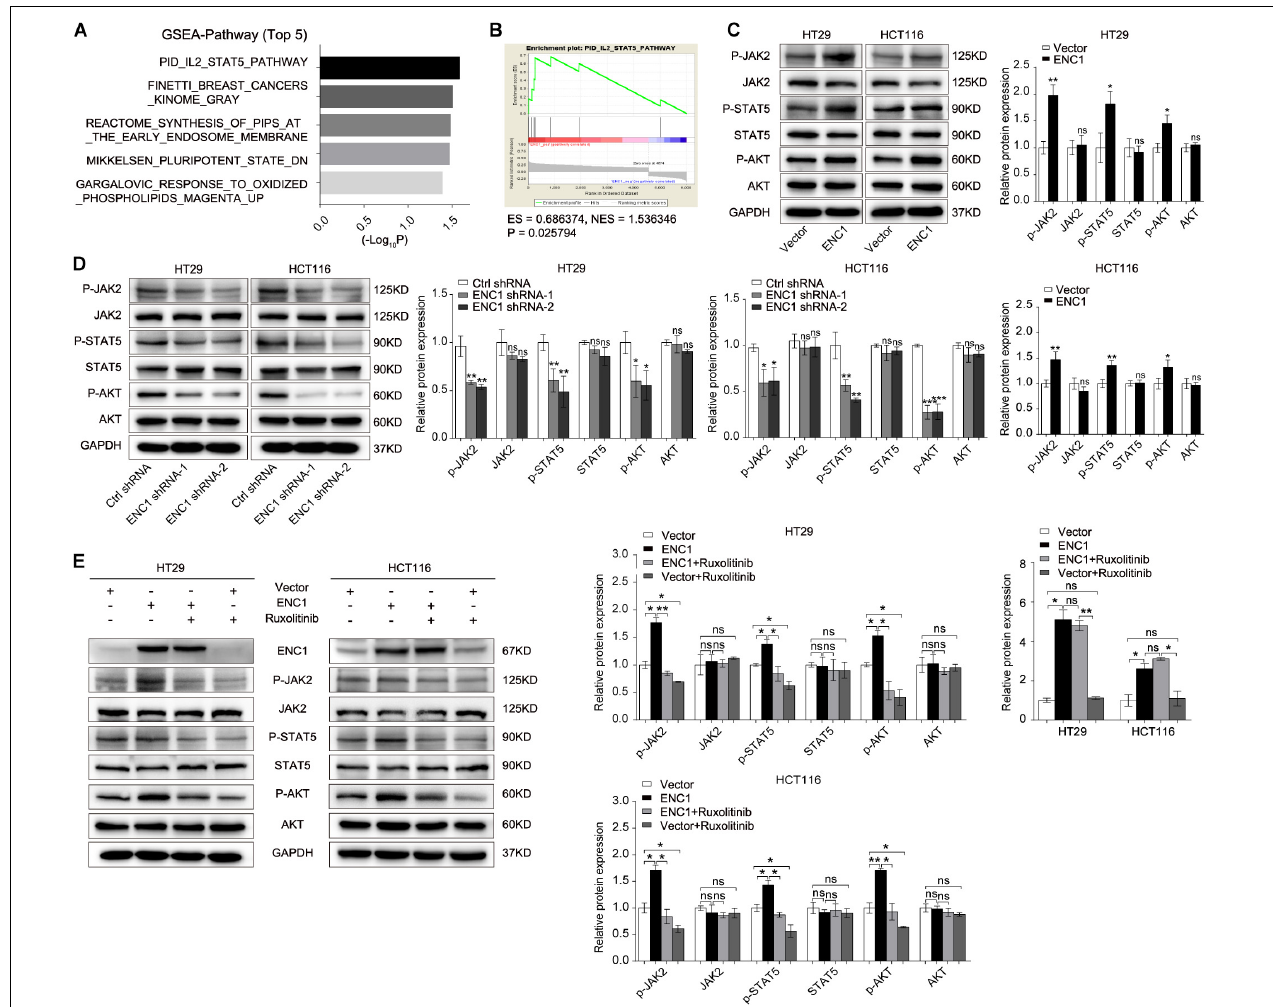
FIGURE 5 | ENC1 activates JAK2/STAT5/AKT signaling in CRC. (A) Top five significantly and positively enriched pathways with high ENC1 expression by GSEA. (B) ENC1 expression positively correlated with STAT5-activated gene signatures (PID_IL2_STAT5_PATHWAY). (C,D) Western blotting analysis of JAK2/STAT5 signaling key members (p-JAK2, p-STAT5, p-AKT, JAK2, STAT5, and AKT) in HT29/HCT116 after ENC1 overexpression and ENC1 knockdown. (E) ENC1-overexpressed HT29/HCT116 were treated with JAK1/2 inhibitor ruxolitinib. After being treated for 24 h, as indicated, p-JAK2, p-STAT5, p-AKT, JAK2, STAT5, and AKT expression levels were detected by western blotting. Results are presented as the mean ± SD of three independent experiments. * P < 0.05, ** P < 0.01, and *** P <